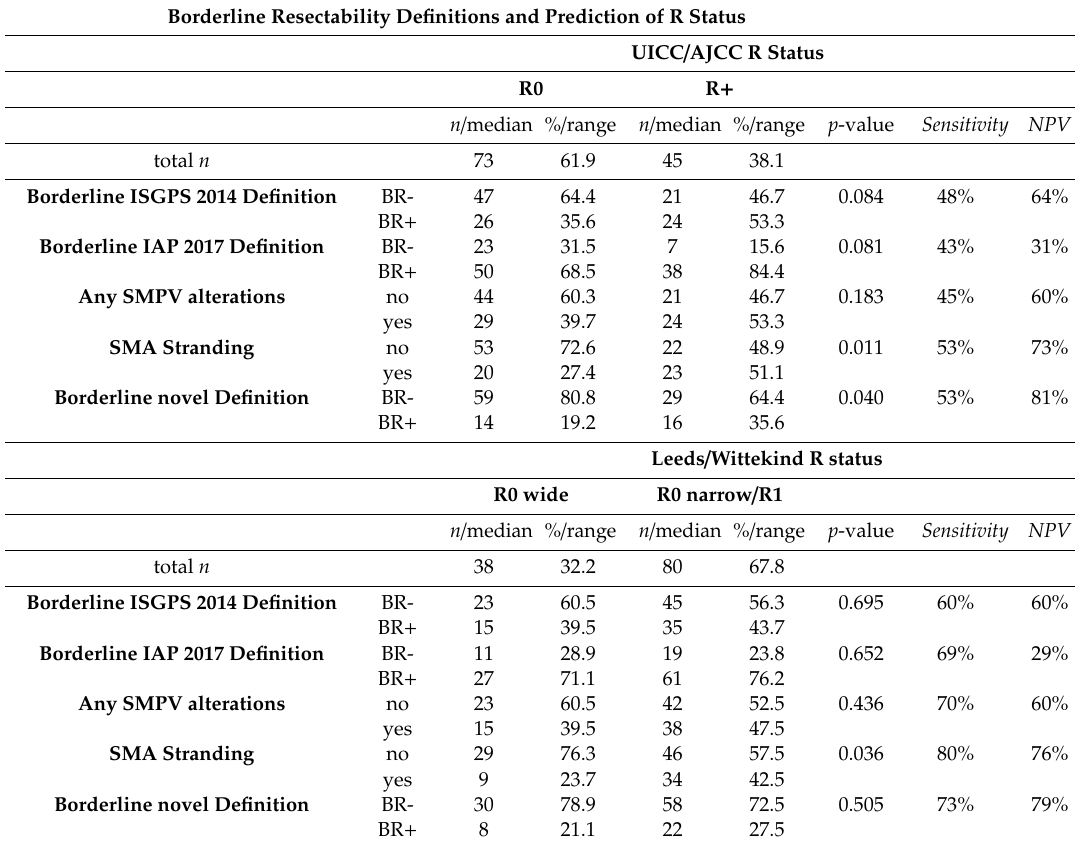
Table 2. Borderline resectability and prediction of R status.